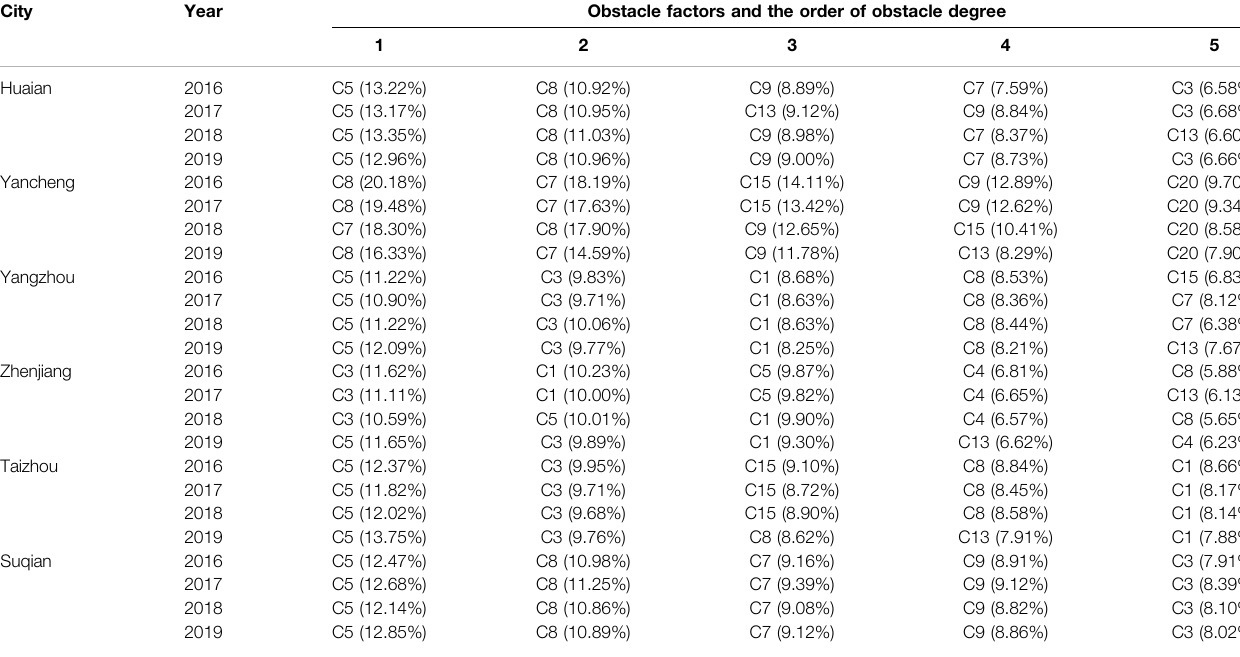
TABLE 5 | Main Obstacle Factors for Sustainable Development of Agriculture in Jiangsu Province and Rank of Obstacle Degree from 2016 to 2019 (Part slowromancapii@)